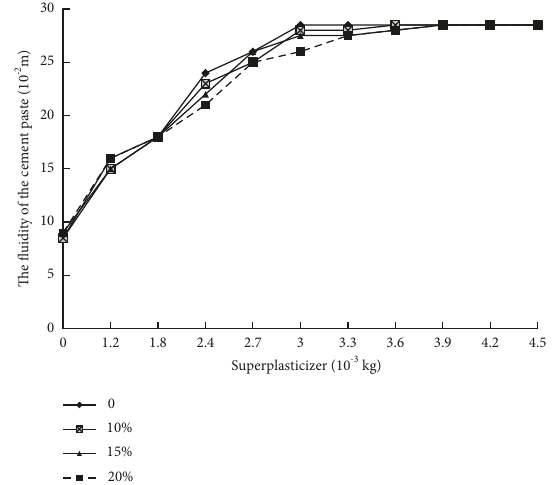
Figure 3: The fluidity change of the cement paste with the superplasticizer